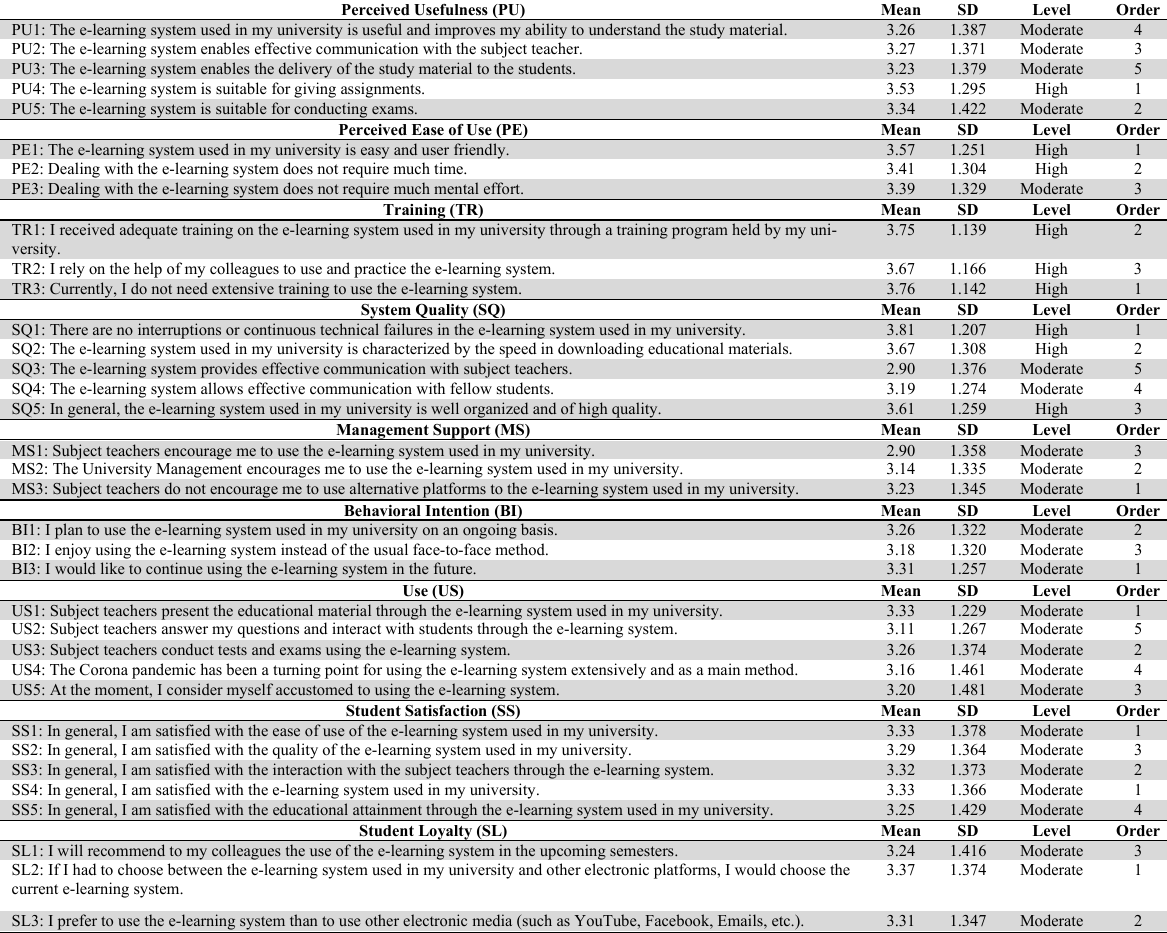
The findings of data analysis have demonstrated, as stated in Table 2, that all research variables are used at moderate levels; whereas respondent’s attribute of Perceived Ease of Use and Use do occur extremely. Table 3 shows the average, standard deviation, level, and order of the scores for each variable's items. Table 3 Mean and standard deviation of the study’s variables Perceived Usefulness (PU)